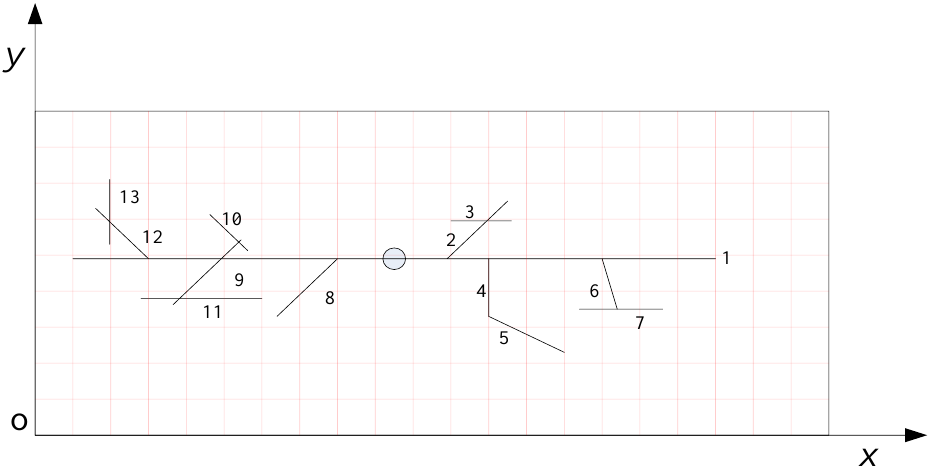
Figure 3. Fine description of fracture system (schematic diagram).